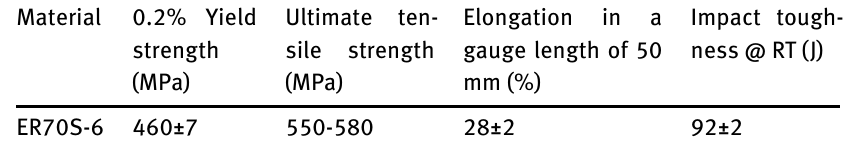
Table 2: Mechanical properties of filler metal (all weld metal).